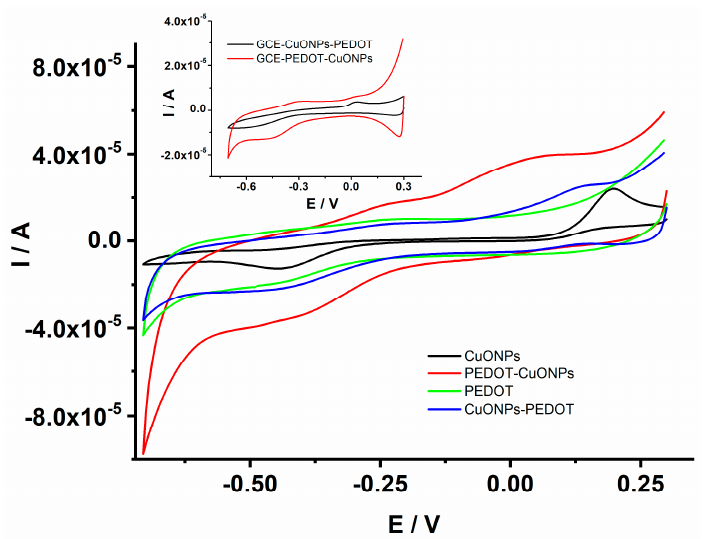
Figure 5. CV traces recorded for the GCE/CuONPs, GCE/PEDOT-CuONPs, GCE/PEDOT, and GCE/CuONPs-PEDOT electrodes in 0.1 M NaOH containing 1 mM H 2 O 2 ; potential scan rate: 50 mV/s. Inset: CV traces for the GCE/CuONPs-PEDOT and GCE/PEDOT-CuONPs electrodes.